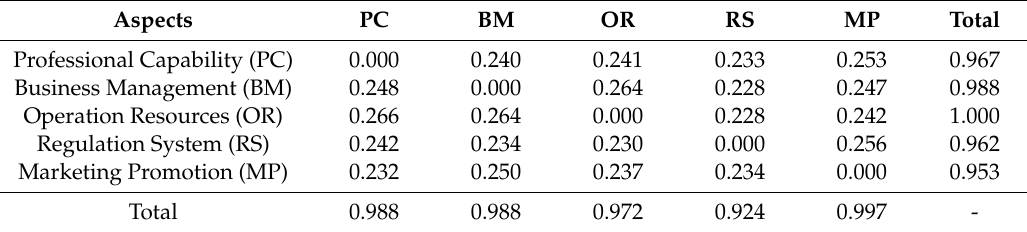
Table 5. The direct influence matrix